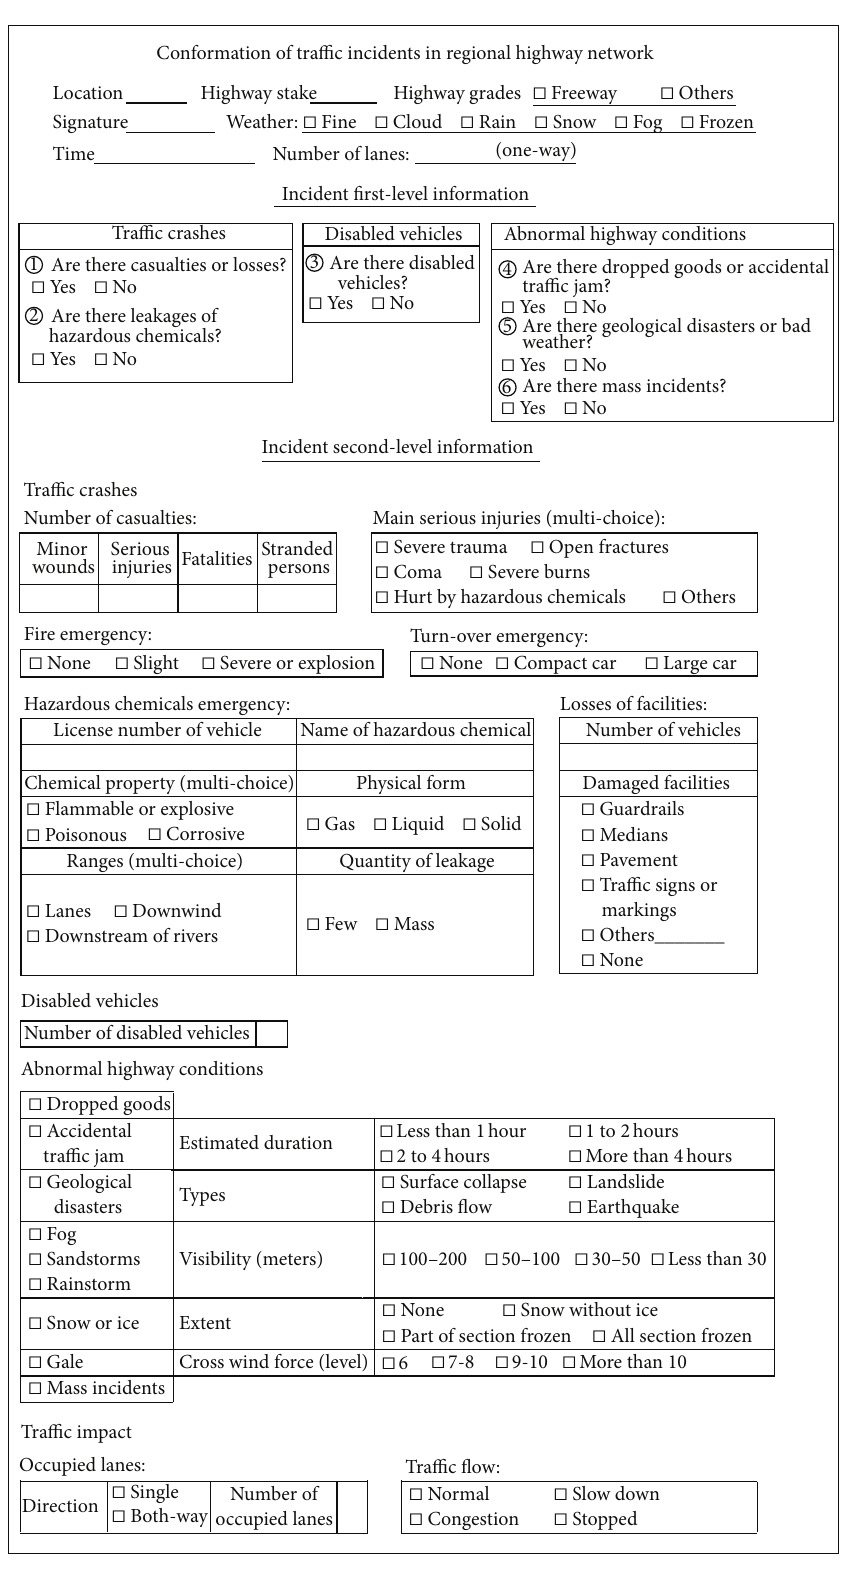
Figure 2: Conformation of Traffic